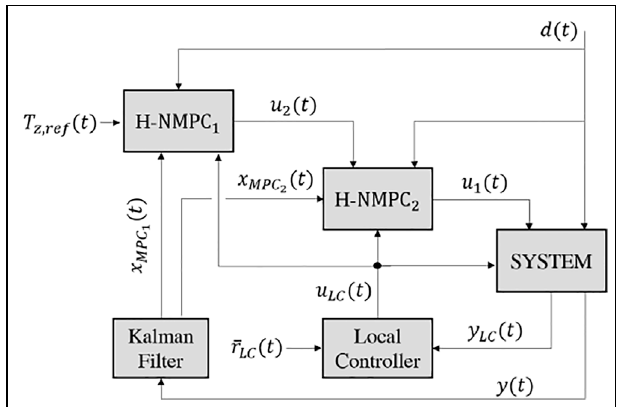
FIGURE 8 | Schematic of H-NMPC structure.